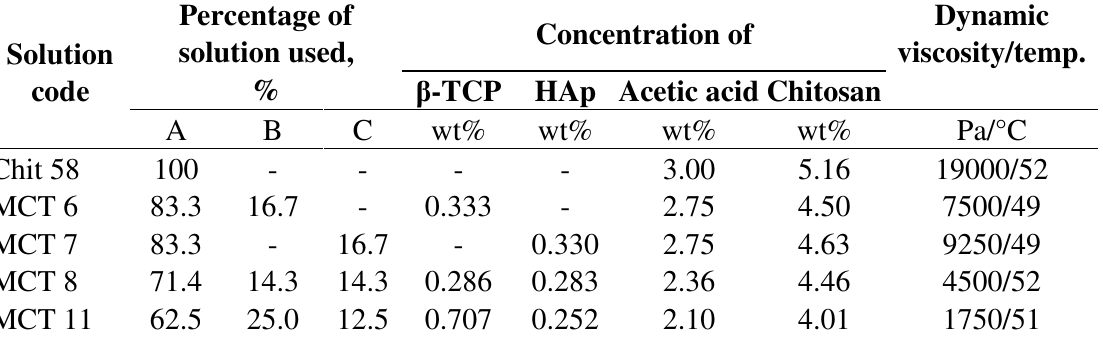
Table 1. Some properties of chitosan solutions containing hydroxyapatite (HAp) and tricalcium phosphate ( β -TCP)